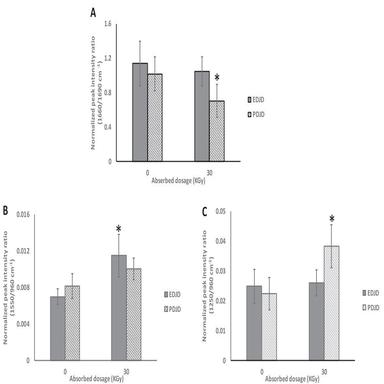
Normalized Raman peak intensity ratios obtained from the EDJD and PDJD regions with or without x-ray irradiation (1660 cm−1 /1690 cm−1 ) that may be indicative of secondary structure changes associated with collagen cross-linking (A). The relative peak intensity of 1550 cm−1 attributable to pentosidine (B). The relative peak intensity of 1250 cm−1 attributable to disordered collagen matrix (C). Five Raman datasets from each tooth were averaged. The mean values of the six teeth were merged. Results are expre